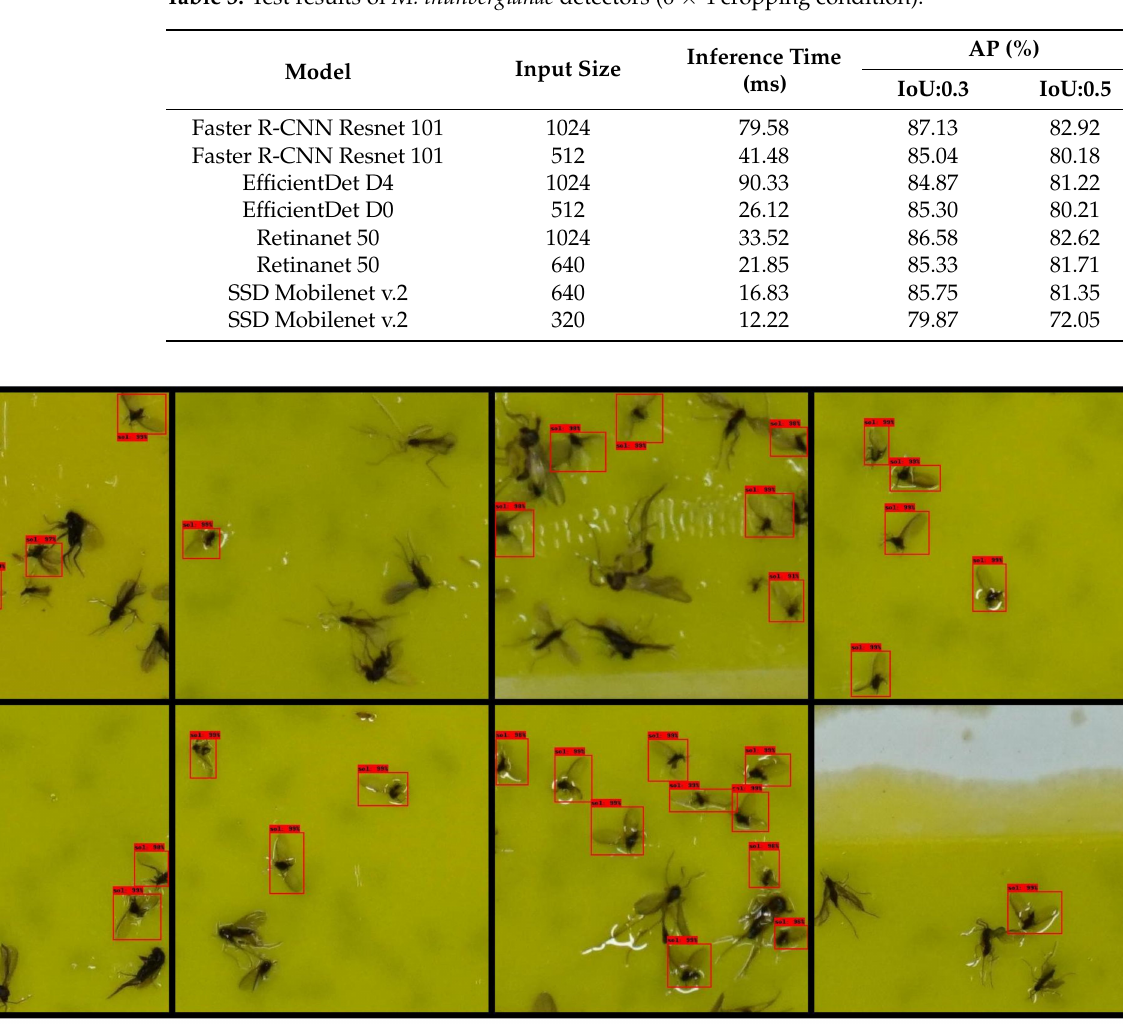
Table 3. Test results of M. thunbergianae detectors (6 × 4 cropping condition).